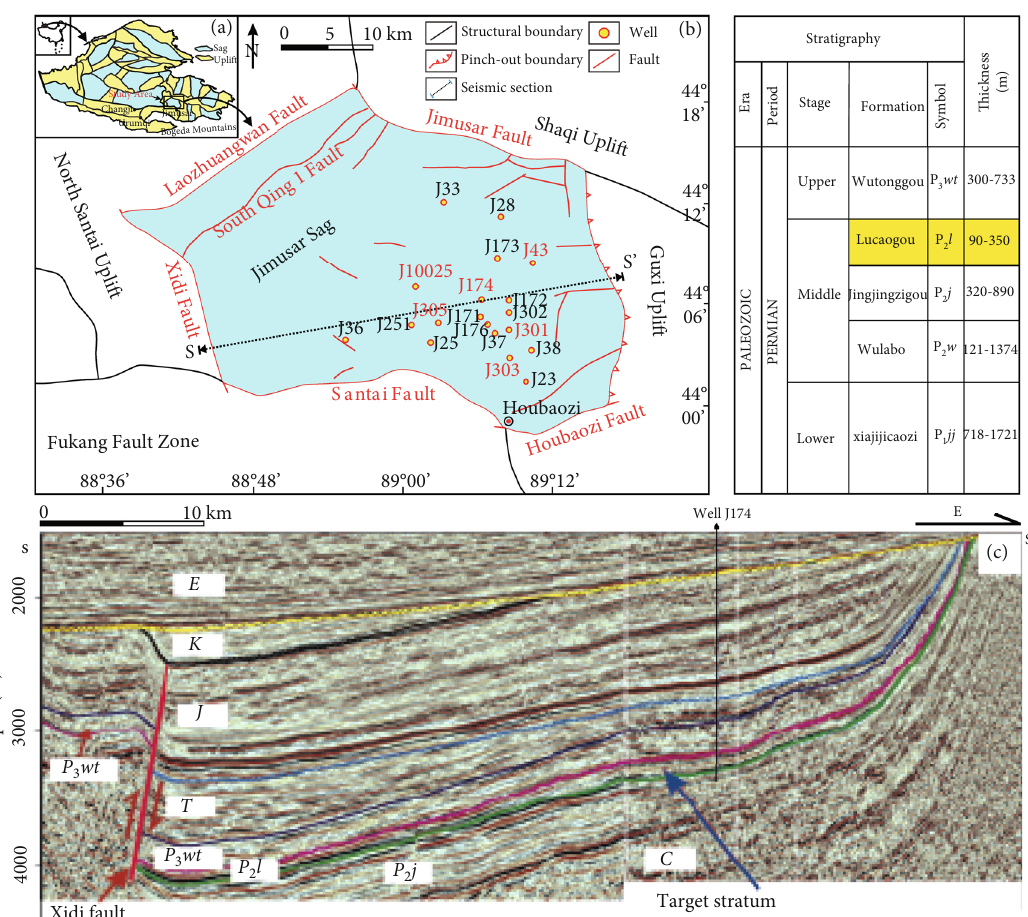
Figure 1: Structural and stratigraphic framework of the Jimusar Sag (modi fi ed after PetroChina Xinjiang Oil fi eld Company ’ s data [46, 75]). (a) Location of the Jimusar Sag in the Junggar Basin. (b) Structural framework and distribution of major wells in the Jimusar Sag. (c) Seismic section showing the stratigraphy of the Jimusar